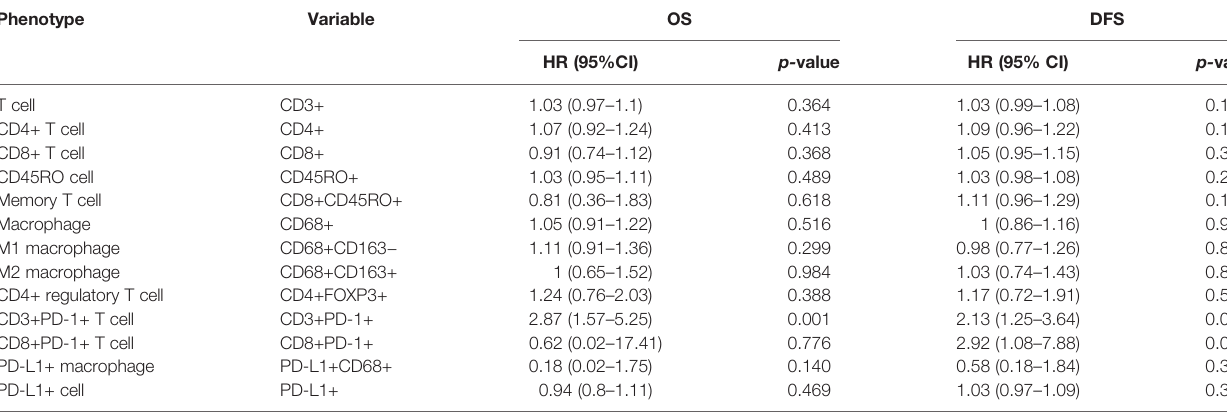
The p-values reported are associated with the Wald test.